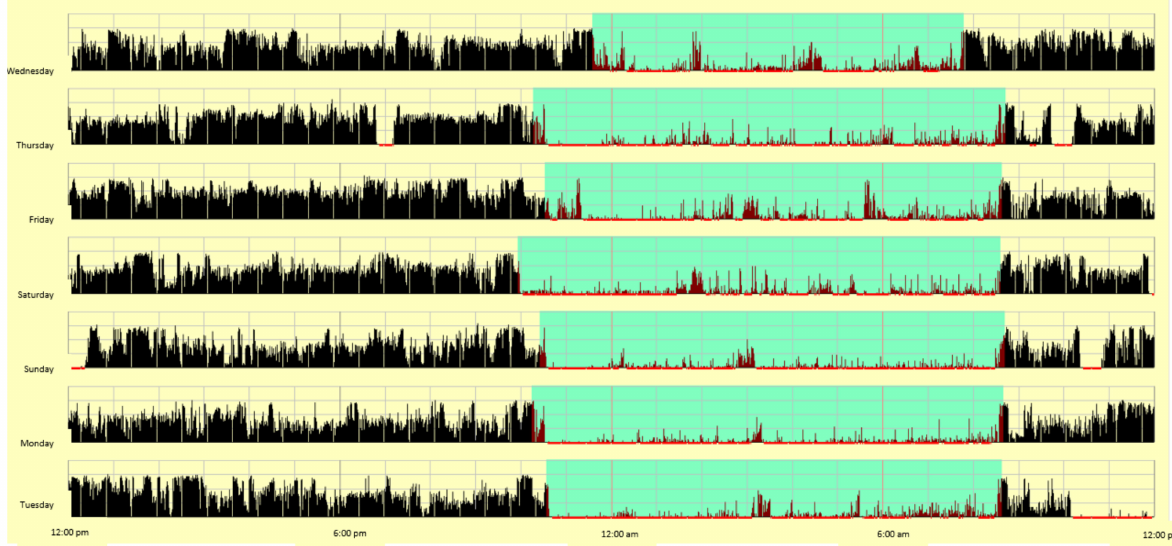
Figure 1. Visual histogram derived from sleep